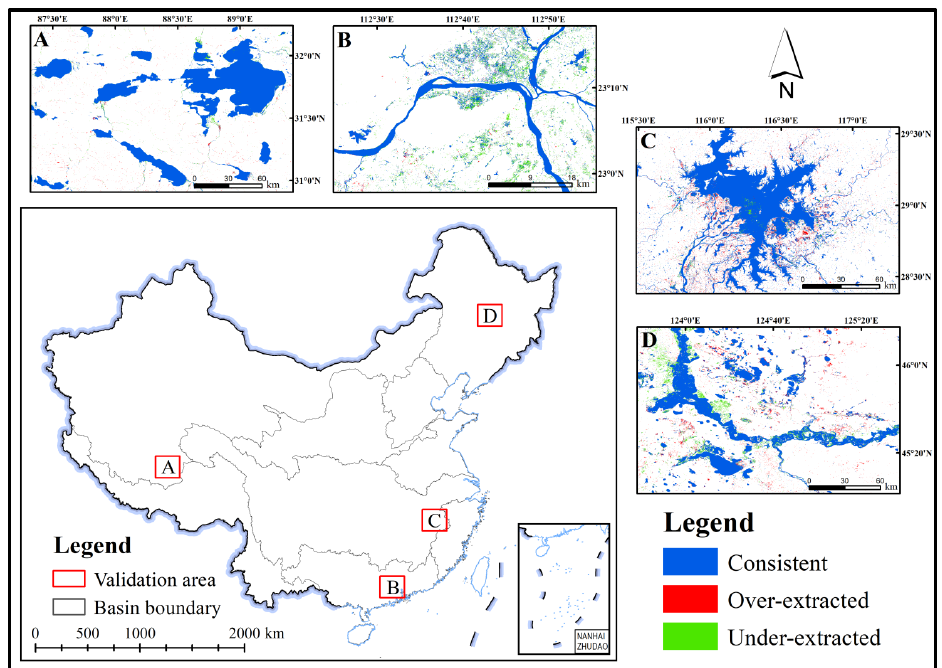
Figure 3. The consistent, over-extracted and under-extracted parts of the China-ASWD compared to the JRC data for regions ( A – D ) in 2019.